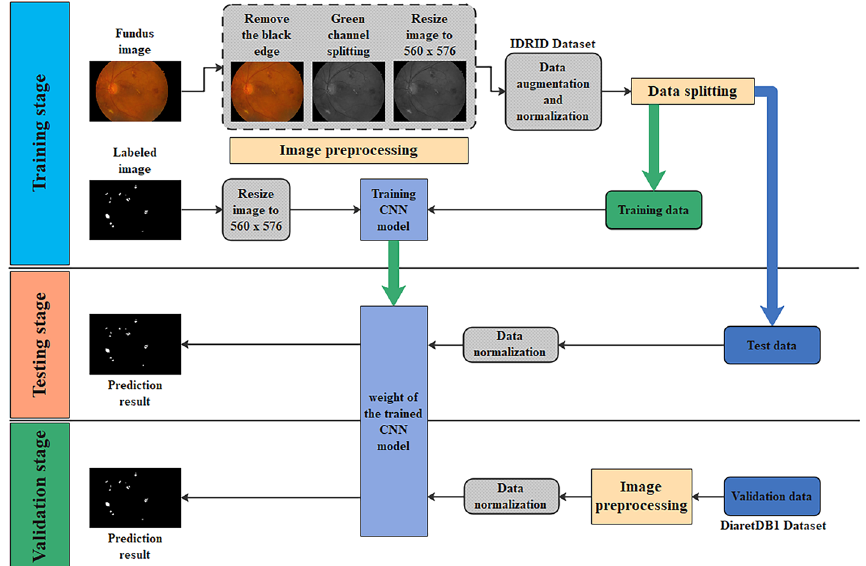
Fig. 5 An overview of the main process of our